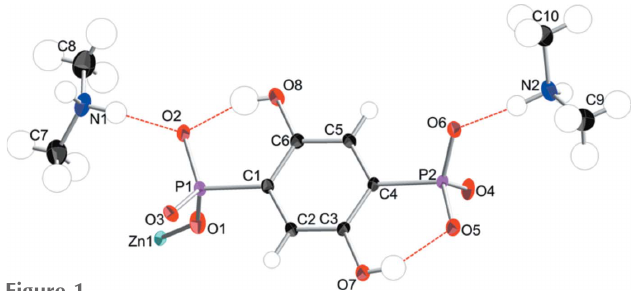
Figure 1 The asymmetric unit of (I) in position 1 (cid:3) x , 1 (cid:3) y , 1 (cid:3) z showing 50% displacement ellipsoids.